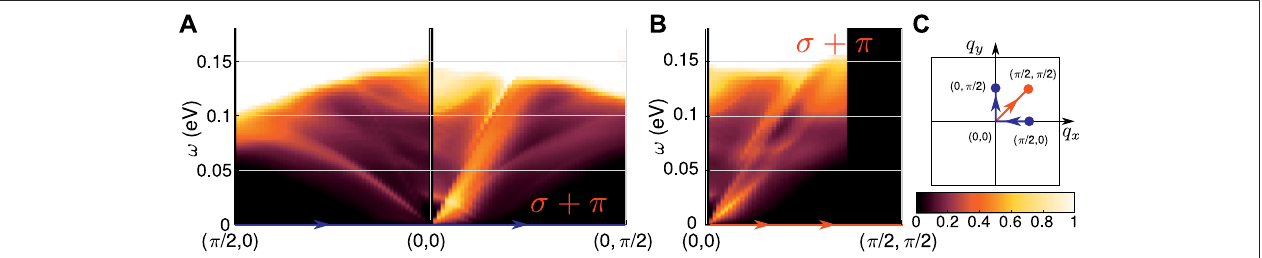
FIGURE 3 | RIXS intensity with orbital-selective quasiparticle weight reduction. The RIXS intensity (see common colorbar) at the accessible momentum transfer exhibits sharp paramagnon-like modes towards q = ( π /2, 0), while towards q = (0, π /2) a broad intensity and a much weaker paramagnon mode is visible (A) . Along the diagonalintheBZ,therearemultiplequasi-sharpparamagnonmodesvisible (B) .Calculatedfor U =0.57eV, J = U /6.Geometryofthepathsalongthediagonal(orange) and along the coordinate axis (blue) as shown in the other panels (C)